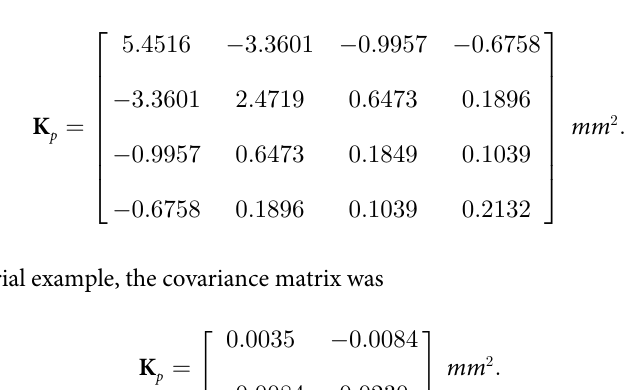
Figs 5 and 6 depict 2D detector images and line profiles of the 1x1 mm, 1x2 mm, and vari- ous SPE derived images for the industrial imaging case. The pore voids are not visible as being 2 distinct defects on the 1x2 image. Images acquired using the 1x1 mm detector do resolve the